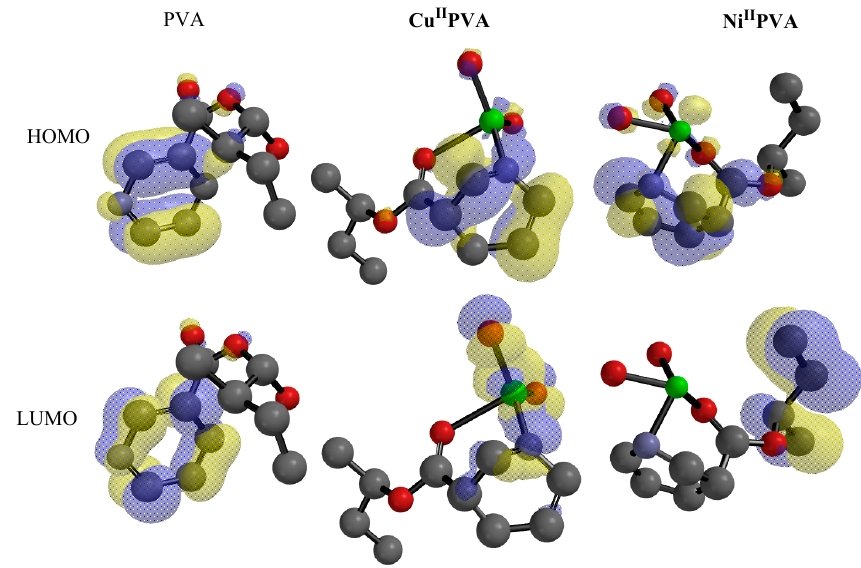
Figure 9. Frontier molecular orbitals (HOMO and LUMO) for PVE, Ni/PVA-NA and Cu/PVA-NA at DFT/BY3LP.